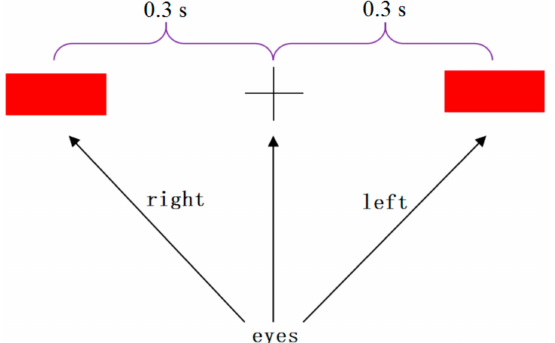
Figure 2. The model of visual evoked